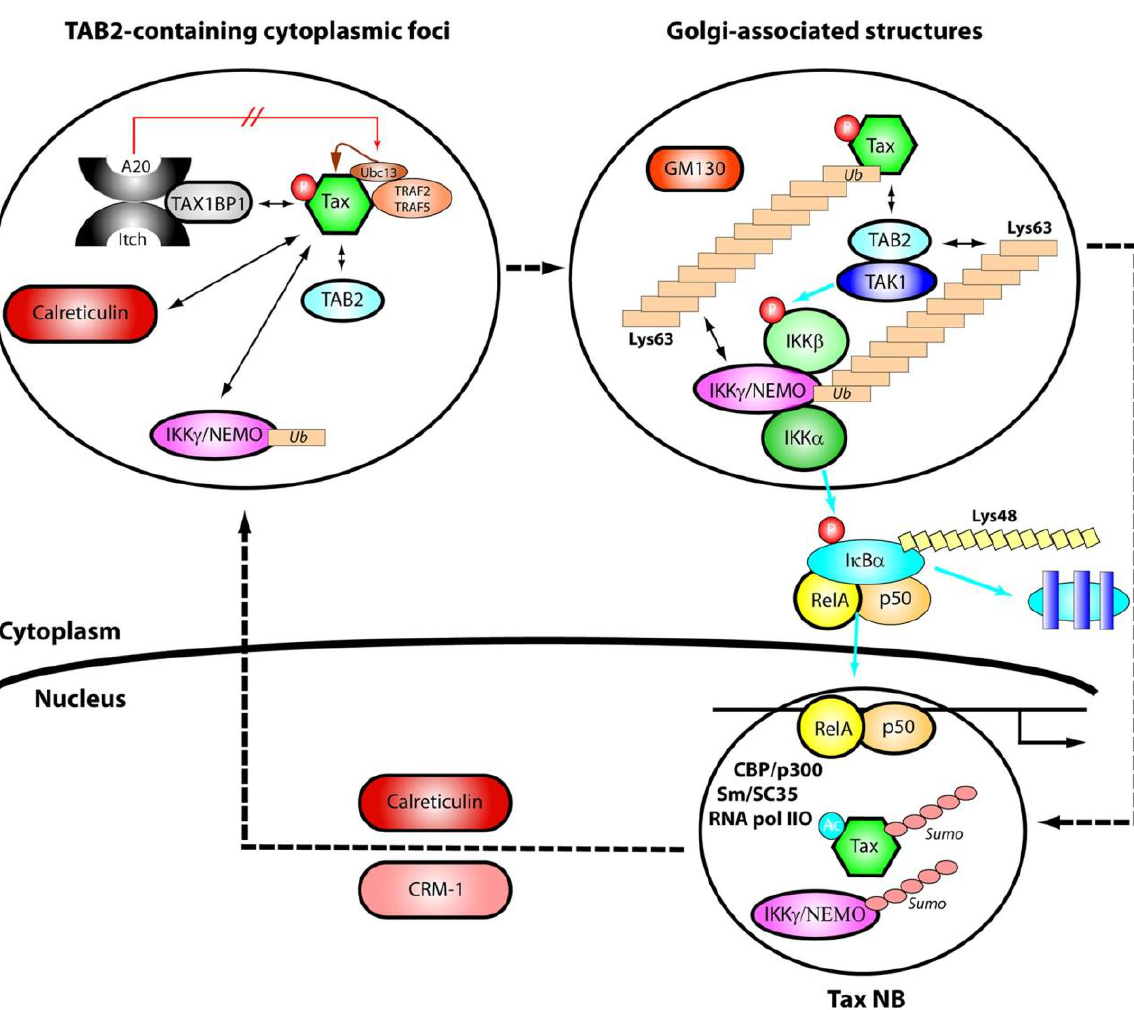
Figure 7. Model for the trafficking of Tax through the cytoplasm and the nucleus and its involvement in Tax-mediated activation of the NF-  B pathway. Dashed arrows denote trafficking of Tax and IKK  /NEMO; dual headed arrows denote relevant protein-protein or protein-polyubiquitin interactions; blue arrows denote effects consecutive to NF-  B activation: phosphorylation of the IKKβ by TAK1, phosphorylation of I  Bα by IKKβ, degradation of I  Bα or migration of p50/RelA complexes to the nucleus. The indications Lys63 and Lys48 denote branching of ubiquitin at the ubiquitin lysine residues 63 or